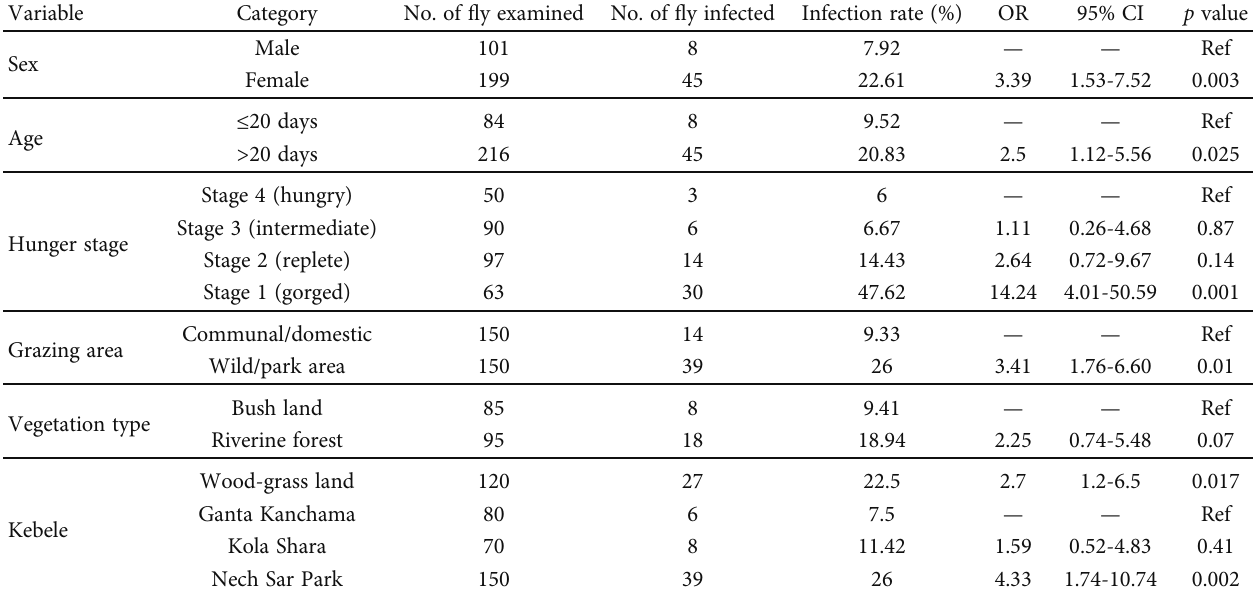
Table 4: Univariable logistic regression analysis for potential risk factors of trypanosome infection in G.